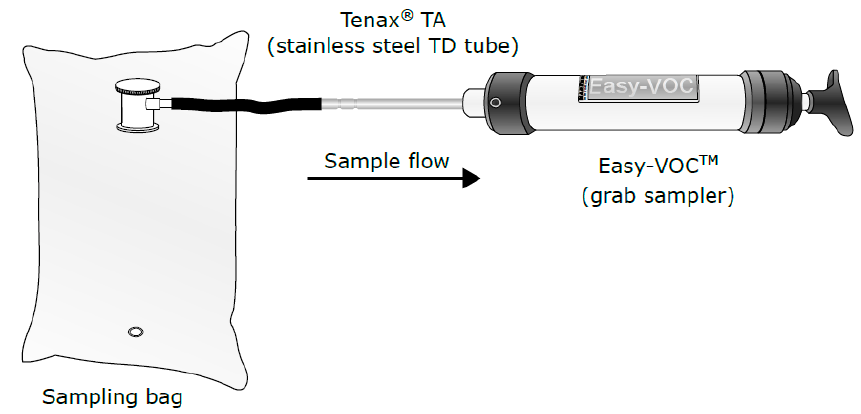
Figure 2. Sampling method 2 — Easy volatile organic compound (VOC) method.